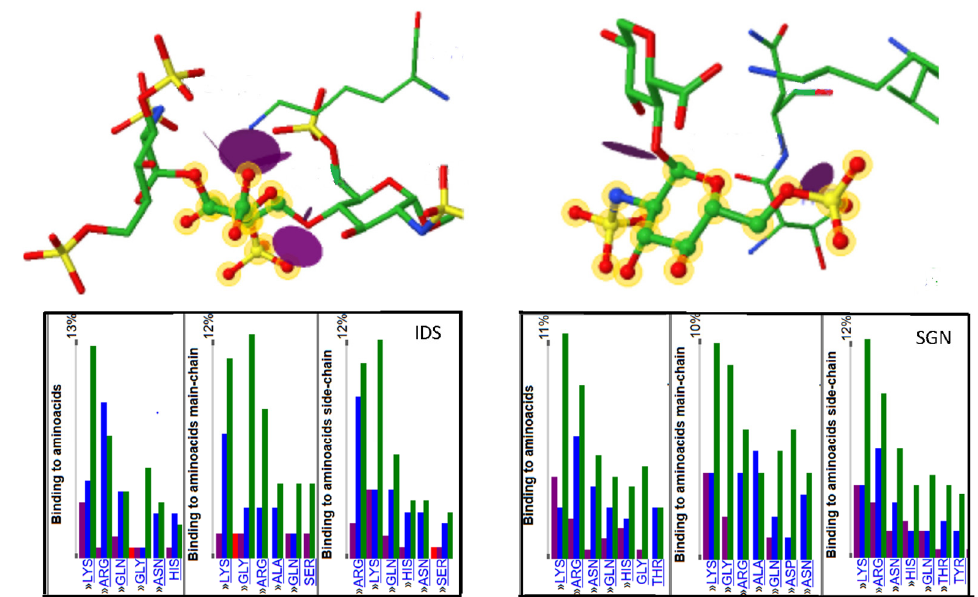
Figure 4. Example of graphical representation of GAG binding site obtained from the PDBe ligand interface. Distribution of the amino acids involved in the binding to GAGs oligosaccharides in cocrystallized complexes. Illustration of two cases showing the hydrogen bonding and electrostatic interaction involved in the interaction. https: // www.ebi.ac.uk / pdbe-site / pdbemotif